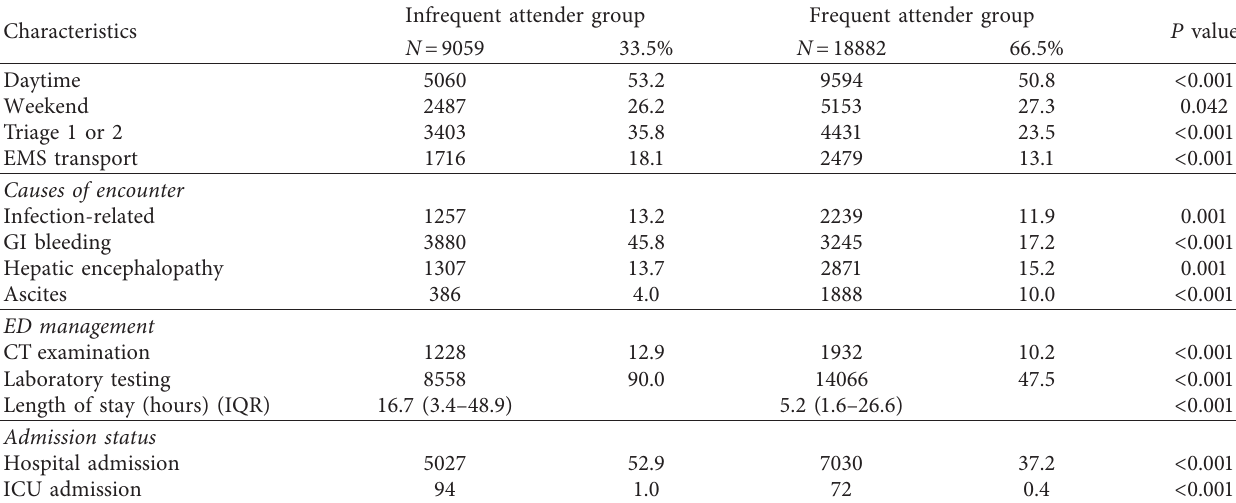
Table 2: Visit characteristics for cirrhosis-related infrequent attenders and frequent attenders.